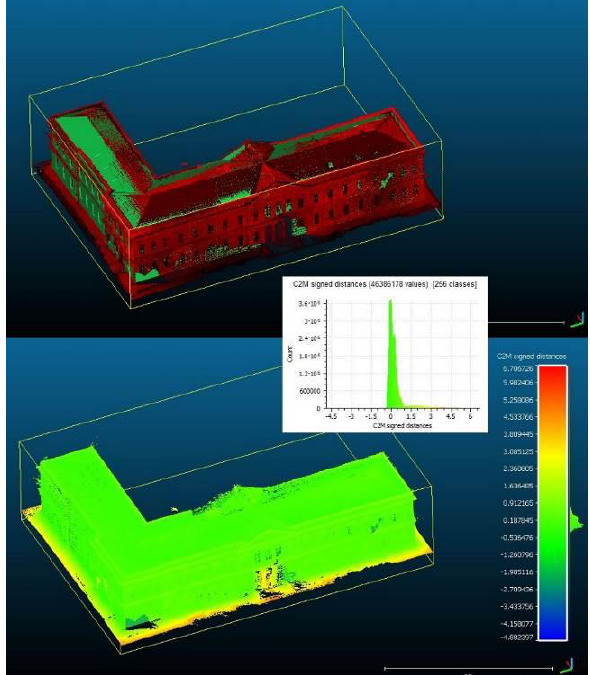
Figure 9 Accuracy of HBIM evaluated by CloudCompare software. Top) Point cloud (red) was overlapped to HBIM (green). Bottom) scalar field from cloud to mesh distance